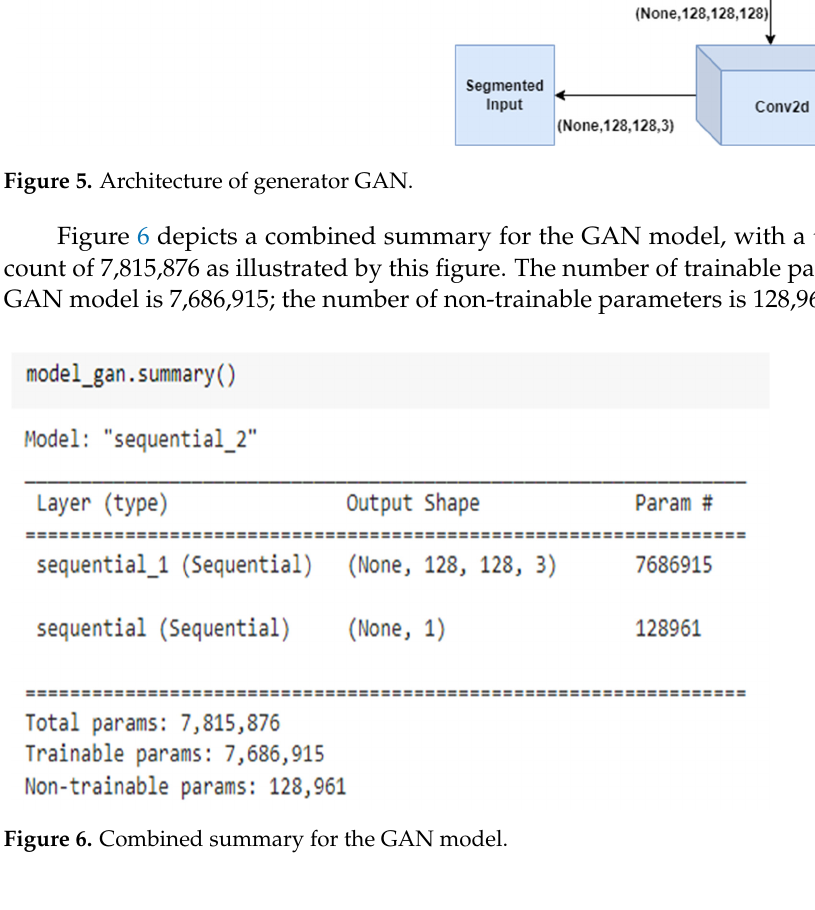
Figure 7. Parameter performance . 6. Results and Observations The model has been trained for 100 epochs, and the quality of the segmented images for some epochs is shown in Figure 8. The first part of image is the input image fed to the